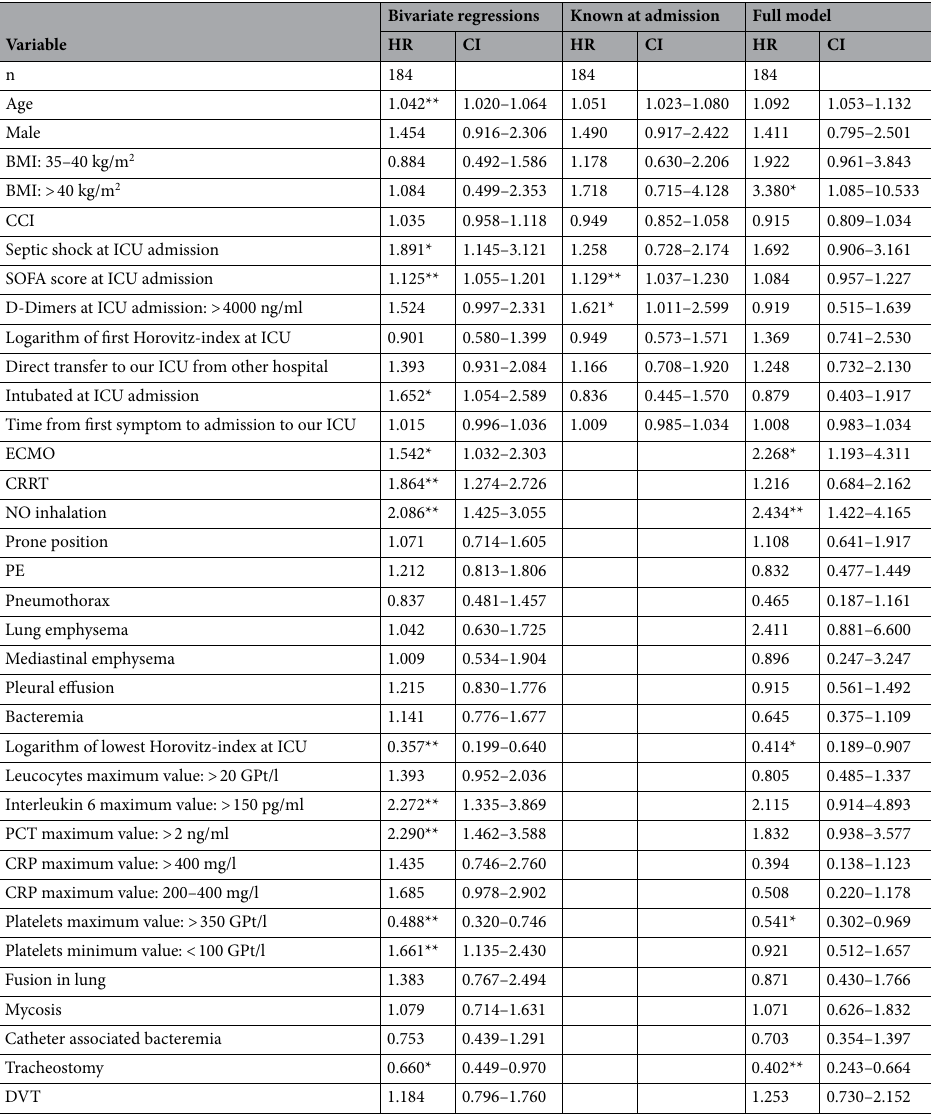
Table 7. Cox regressions for hospital mortality. Hazard ratios with 95%-confidence intervals for hospital mortality from bivariate Cox regression, Cox regression including covariates known at admission and Cox regression including all covariates (full model) (significance levels: * = 5%, ** = 1%). BMI Body-Mass-Index, CCI Charlson ComorbidityIndex, CI Confidence interval, CRP C-reactive protein, CRRT Continuous renal replacement therapy, DVT Deep vein thrombosis, ECMO extracorporeal membrane oxygenation, HR Hazard ration, ICU Intensive care unit, NO Nitric oxide, PCT Procalcitonin, PE Pulmonary